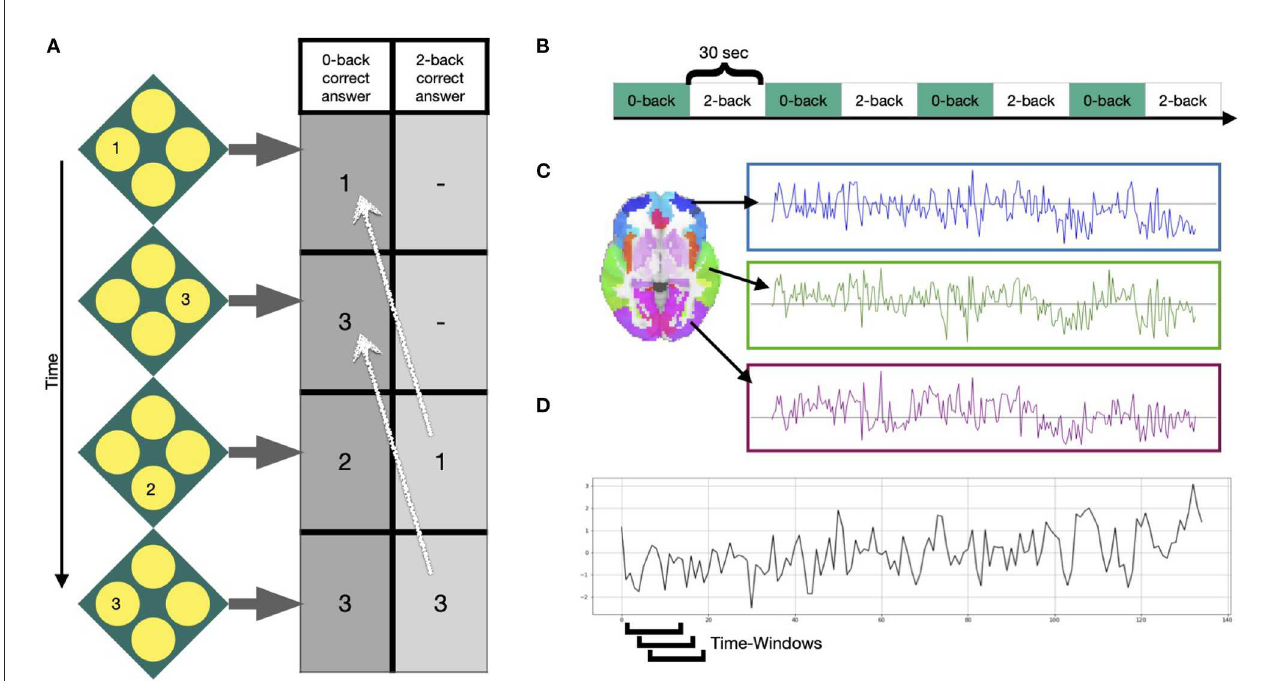
FIGURE2 Task and signals. (A) Example of the N-back working memory task with a 0-back and 2-back condition, during which participants were asked to choose the value that was either shown at the current step or 2 steps ago, respectively. (B) Four blocks of each condition were presented in alternated fashion for 30s. (C) After preprocessing, mean time courses were extracted from 246 Brainnetome atlas regions (Fan et al., 2016). (D) Windowed time series were extracted using a sliding-window approach, moving a window of 15 time points over the time series one volume at a